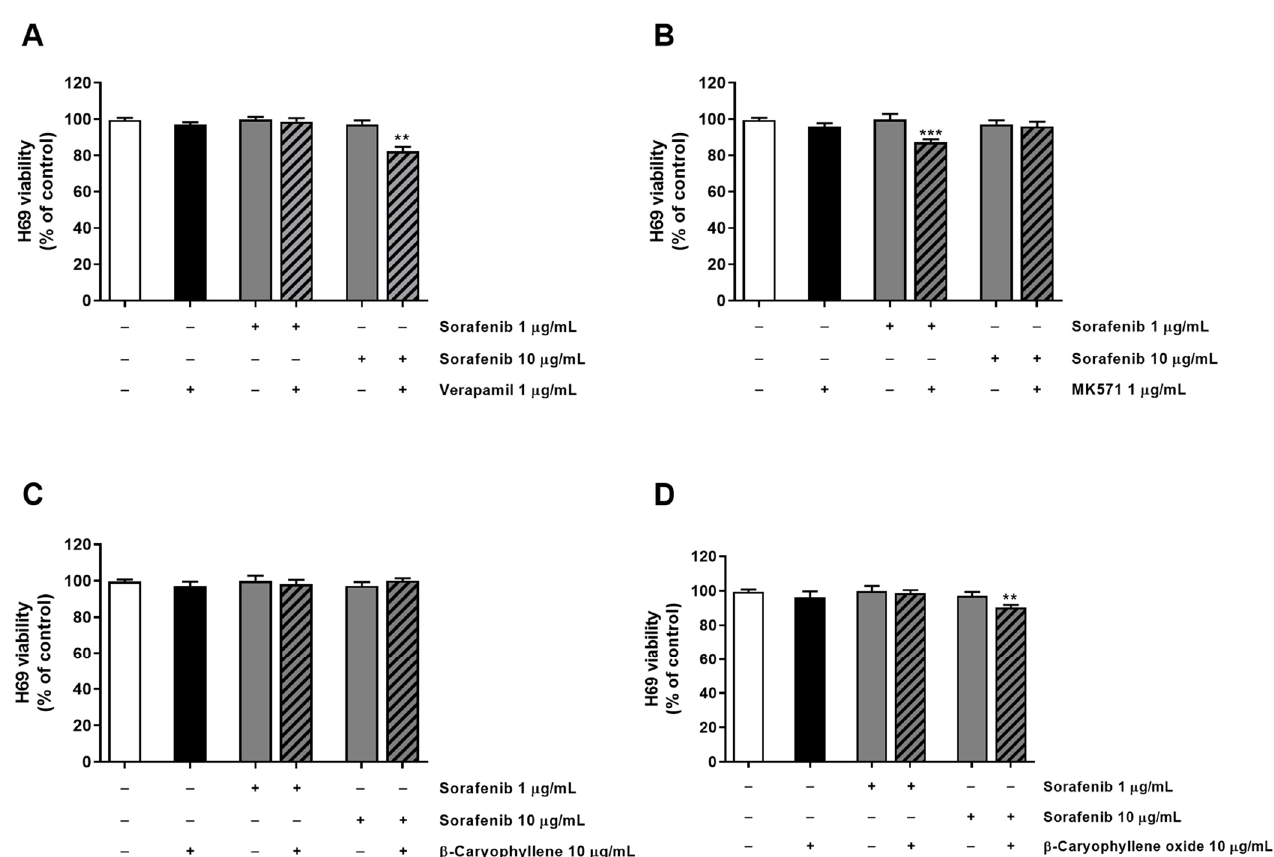
Figure 5. Cytotoxicity of sorafenib in combination with verapamil ( A ), MK571 ( B ), β -caryophyllene ( C ), and β -caryophyllene oxide ( D ) in noncancerous H69 cholangiocytes after 4 h exposure and 72 h recovery time. Data displayed as mean ± SE of at least three independent experiments ( n = 3). ** p < 0.01 and *** p < 0.001 vs. sorafenib alone (Student’s t -test).